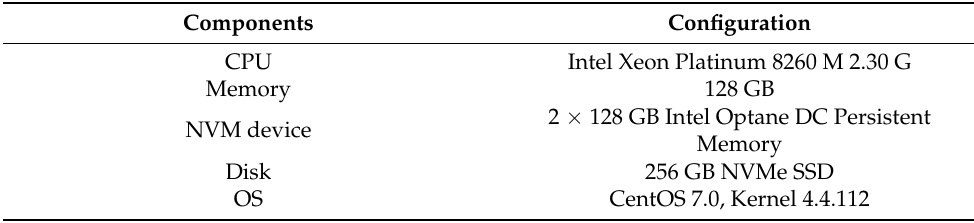
Table 1. Configuration of evaluation.